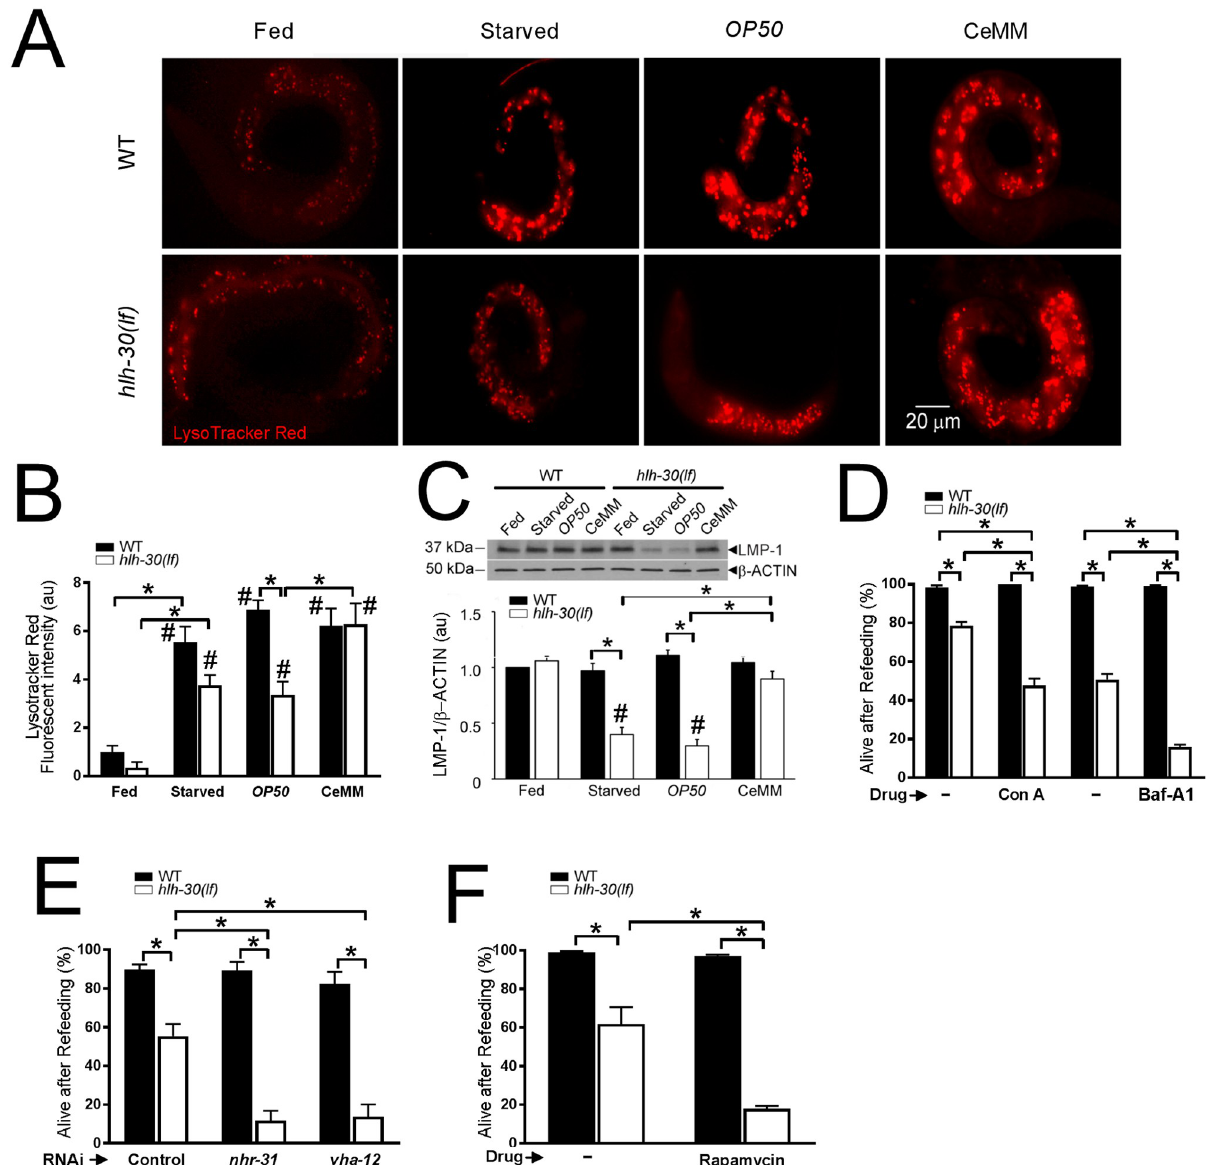
Fig 6. CeMM bypasses hlh-30 to restore lysosome acidification and TOR activation and confer survival in hlh-30(lf) worms. (A, B) Representative fluorescence images (A) with quantification of fluorescence intensity (B) of LysoTracker Red staining. WT and hlh-30(lf) L1 worms were analyzed in the fed state (Fed) or after 33 hours of starvation (Starved) followed by 15 hours on E . coli OP50 -seeded NGM dishes ( OP50 ) or 15 hours of incubation in CeMM (CeMM). Scale bar is 20 μ m. For panel B, WT fed value was set equal to 1.0, and other values were normalized to this value. N = 8–23 worms/ condition. � P < 0.05 for comparisons as indicated by post hoc test after one-way ANOVA. # P < 0.05 versus respective fed state by post hoc test after two-way ANOVA. (C) Representative immunoblot ( top ) and quantification ( bottom ) of LMP-1 protein abundance (normalized to β -ACTIN as a loading control) in WT and hlh-30(lf) L1 worms cultured as described in A. WT fed value was set = 1.0. N = 5–7 biological replicates/group. � P < 0.05 for comparisons as indicated by post hoc test after two-way ANOVA. # P < 0.05 versus the respective fed state by post hoc test after one-way ANOVA. (D) Measurement of “Alive after Refeeding” as in Fig 1A in WT and hlh-30(lf) worms starved as L1 stage larvae for 33 hours, then transferred to CeMM for 15 hours in the presence of Con A or Baf-A1 with DMSO as control (depicted as “–”), and transferred to E . coli OP50 dishes. DMSO concentrations employed to dissolve Con A and Baf-A1 were 0.34% and 1.2%, respectively. N = 4–5 biological replicates/group. � P < 0.05 by post hoc test after two- way ANOVA. (E) Assessment of “Alive after Refeeding” in WT and hlh-30(lf) worms starved as L1 stage larvae for 33 hours, transferred to CeMM containing dsRNA targeting nhr-31 , vha-12 , or L4440 as control for 15 hours, and transferred to E . coli OP50 dishes for 48 hours. N = 4–9 biological replicates/group. � P < 0.05 by post hoc test after two-way ANOVA. (F) “Alive after Refeeding” measured as described in Fig 1A in WT and hlh-30(lf) worms starved as L1 stage larvae for 33 hours, then transferred to CeMM for 15 hours in the presence of rapamycin with DMSO (100%, employed as diluent; indicated as “–”) followed by transfer to E . coli OP50 dishes containing rapamycin. N = 6 biological replicates/group. � P < 0.05 by post hoc test after two-way ANOVA. In all cases, bars indicate mean ± SEM. Raw data for B–F are in S1 Data. Baf-A1, bafilomycin A1; CeMM, C . elegans